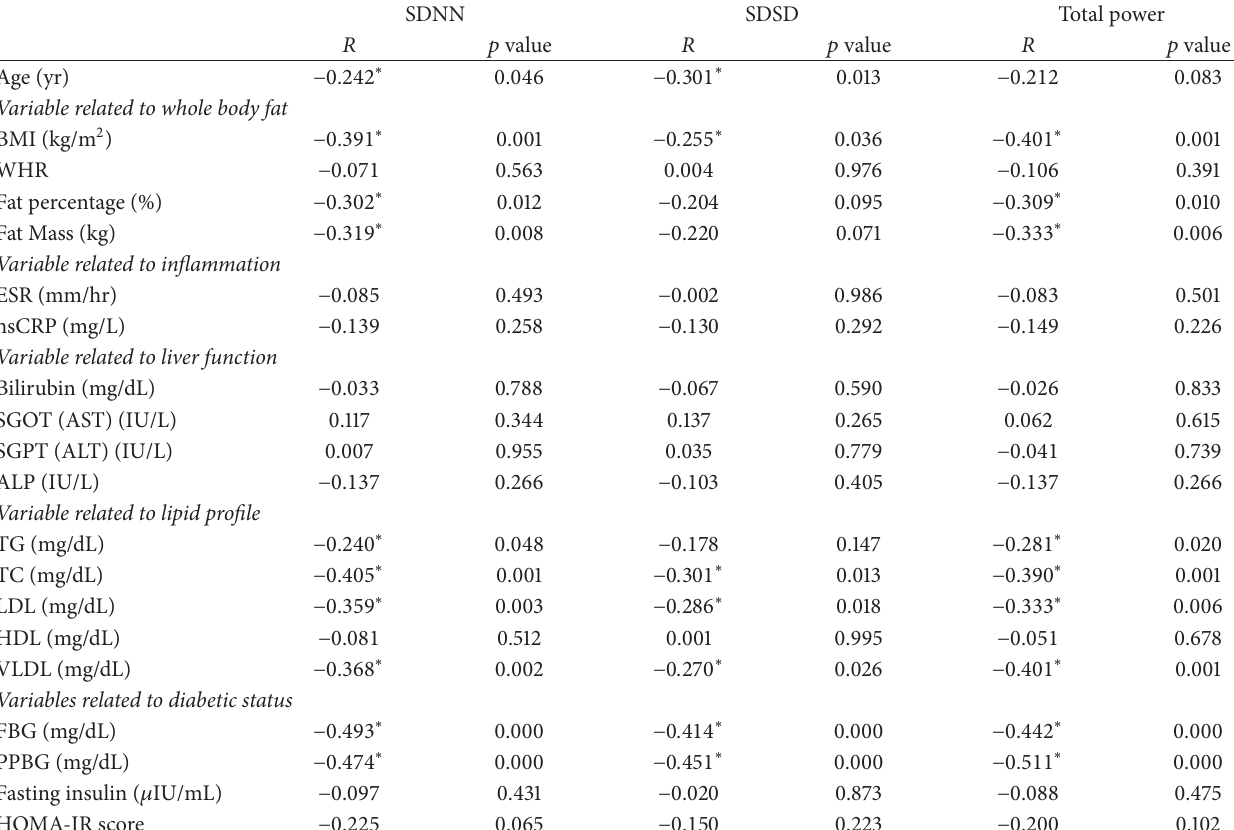
Table 5: Linear correlation analysis between the indices of HRV (dependent) and independent variables.